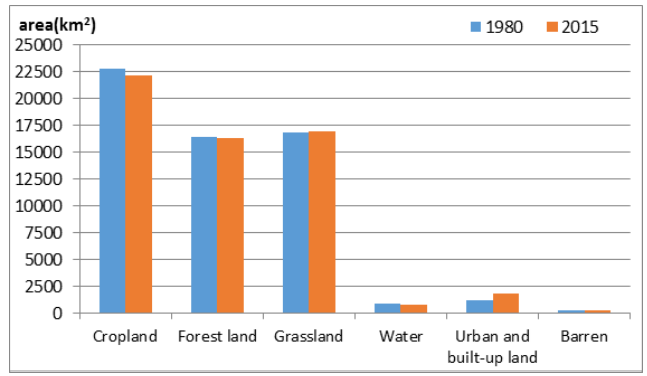
Figure 4. Land use categories for the study area in 1980 and 2015.